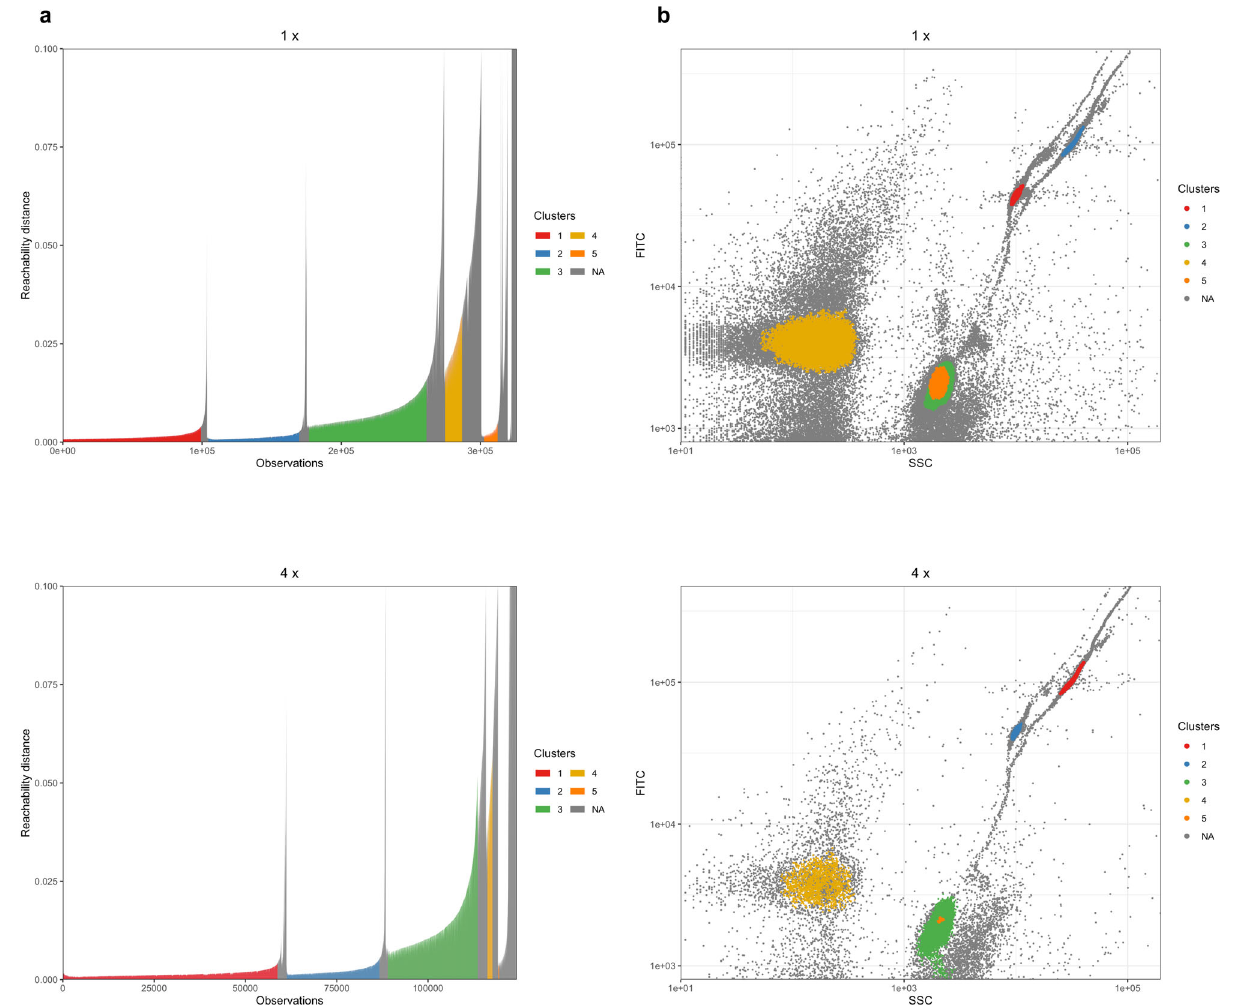
Fig. 4 Representative results of manually extracting clusters from OPTICS-ordered data collected from 1× and 4× dilutions tested in mixed-target experiment. Representative results for additional dilutions are available in Supplementary Fig. 4. Panel a plots show the OPTICS ordering of the data from which the clusters were manually extracted. Colors highlight each manually extracted cluster. Panel b plots visualize the data as SSC vs. FITC plots, with points colored based on the cluster extraction. Cluster colors are consistent between the two plots for each dilution, but not necessarily between different